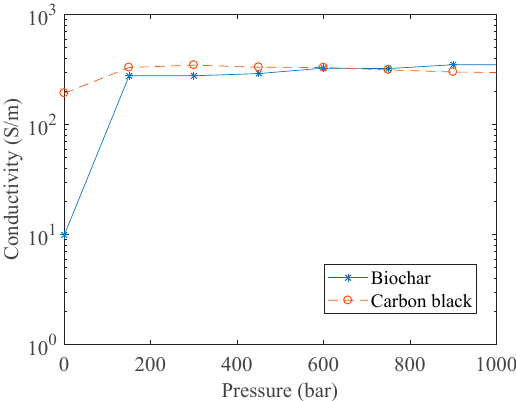
Figure 8. Conductivity measurement (DC) of thermal annealed sludge biochar and carbon black (*Vulcan ® XC72R) as a function of applied pressure (0–1000 bar).